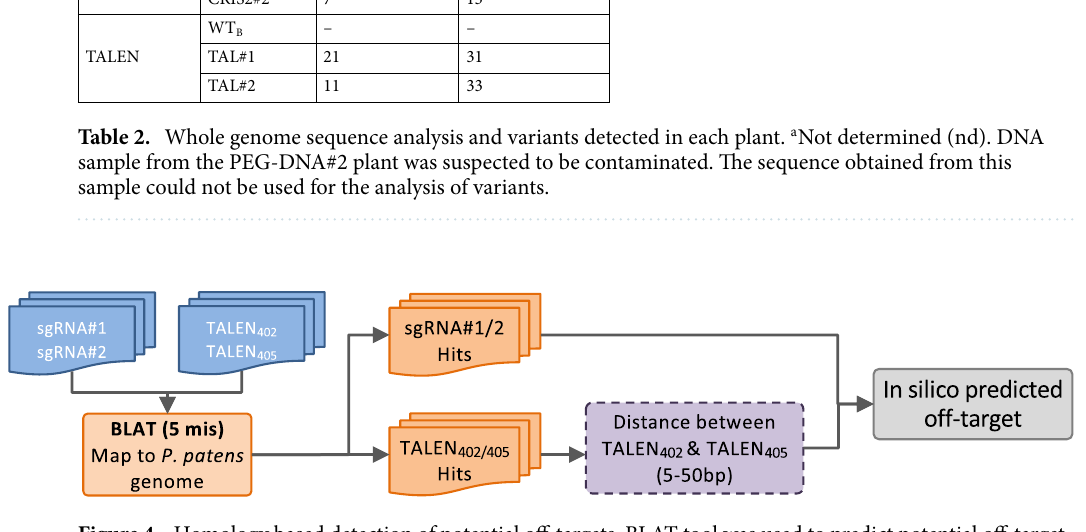
Figure 4. Homology based detection of potential off-targets. BLAT tool was used to predict potential off-target sequences. Results were crossed with detected mutations from WGS variant